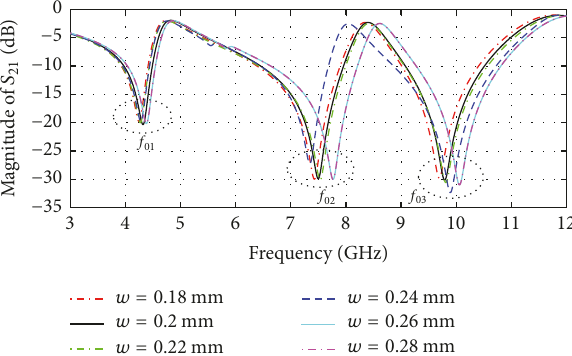
Figure 12: Transmission spectra of the TBEMR for different values of metal line width 𝑤